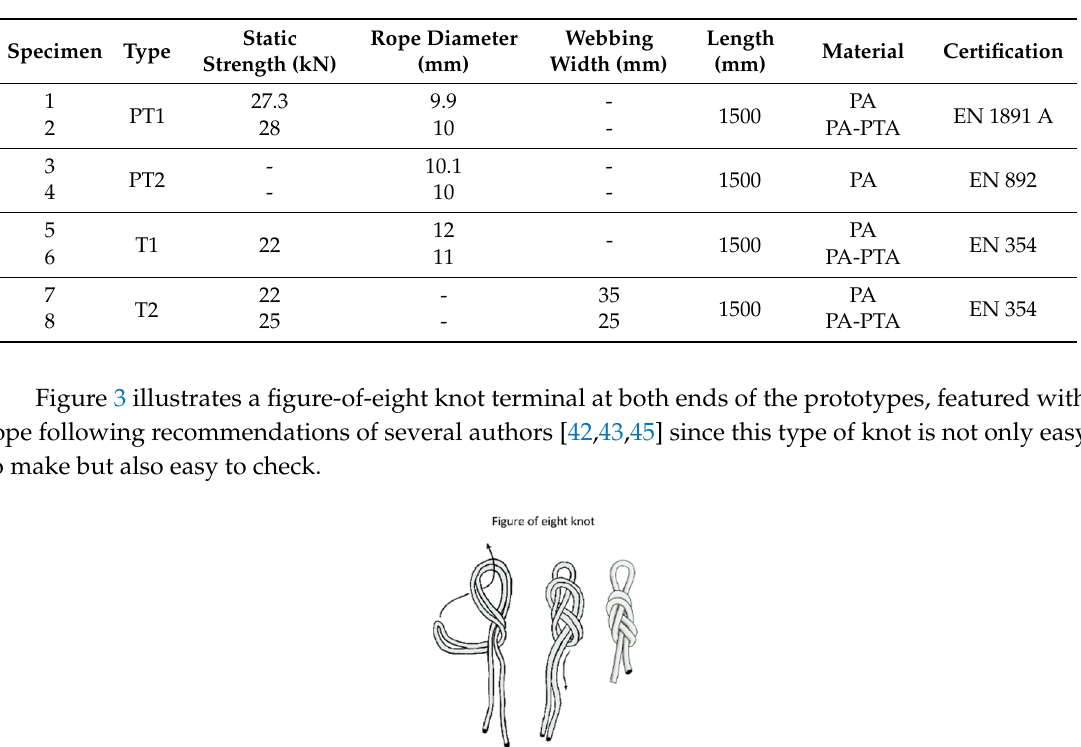
Table 4. Test specimen specifications.